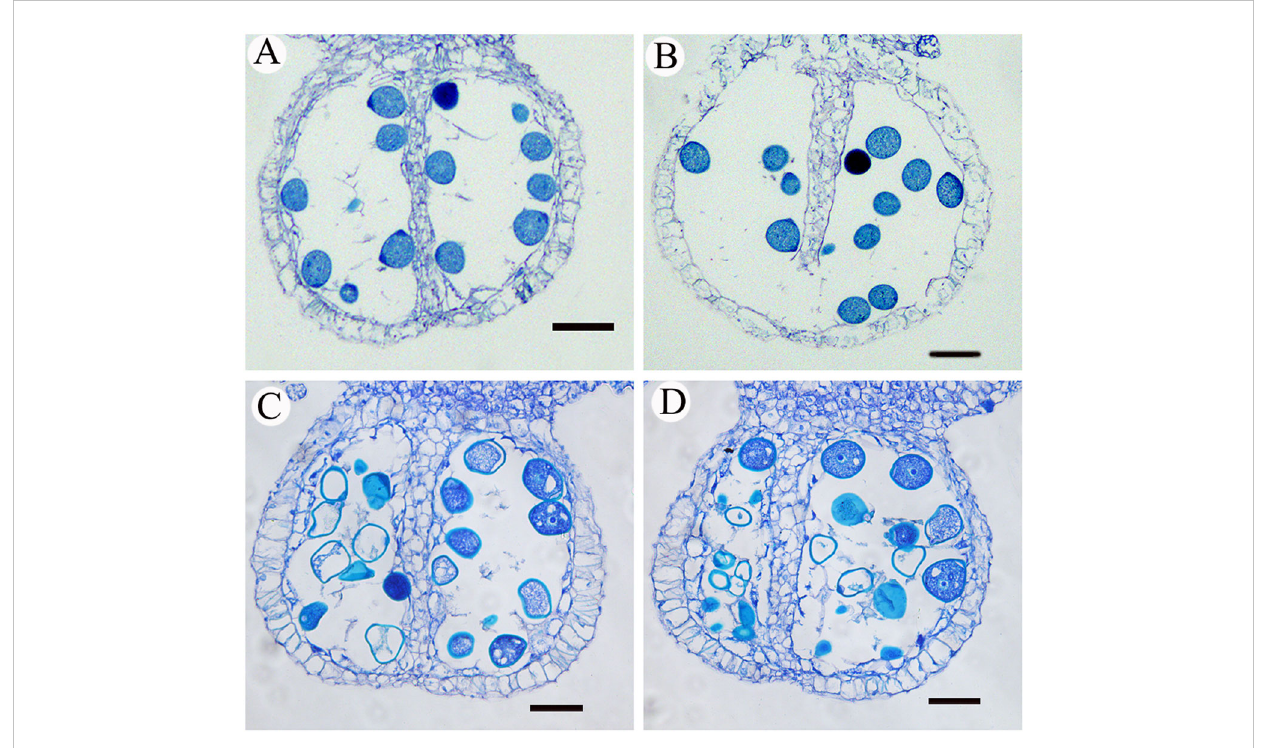
FIGURE 2 The cross-section analysis of mature anther. (A, B) Anther cross sections of the mature stage in normal condition; (C, D) the cross-sections of mature anther with high-temperature stress. Bar = 50 m